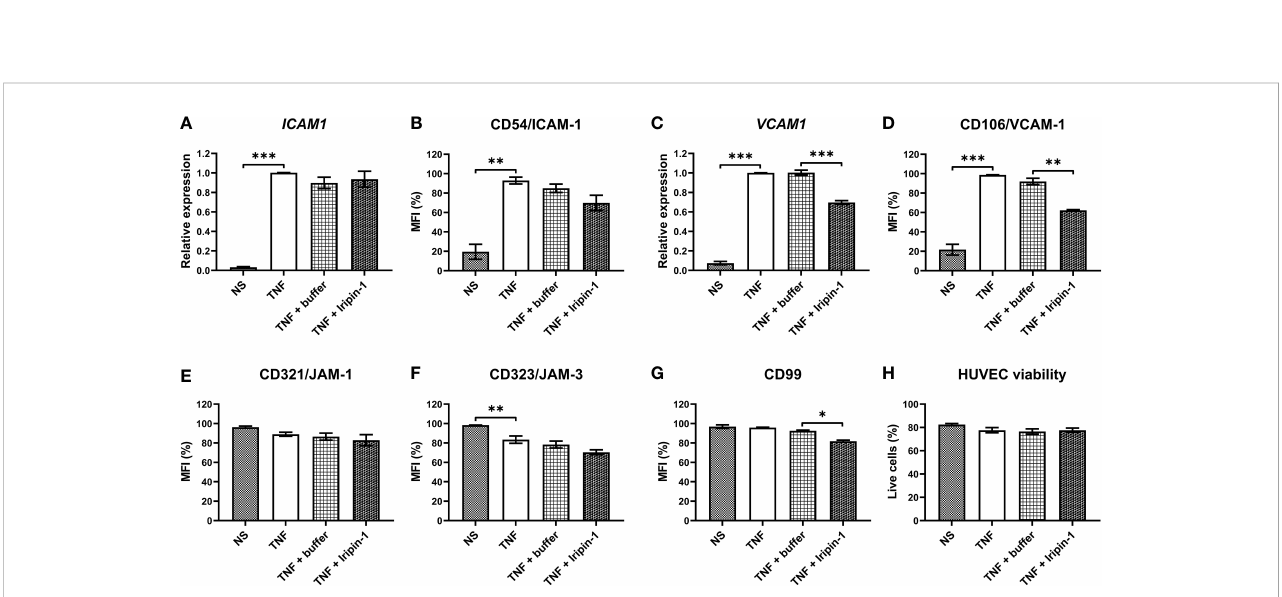
FIGURE 9 Iripin-1 modi fi es the expression of cell adhesion molecules in TNF-stimulated HUVECs. (A, C) HUVEC incubation in the absence of TNF (NS, unstimulated cells) or in the presence of TNF (10 ng/mL), Iripin-1 (2 m M), and control buffer for 4 h was followed by the isolation of total RNA and RT-qPCR analysis to determine the expression level of ICAM1 (A) and VCAM1 (C) . Relative expression values were calculated using the Pfaf fl method (46) and a combination of two reference genes GAPDH and HPRT1 . Cells treated with TNF only were used as a calibrator during calculations. (B, D-H) HUVECs were cultured in the absence of TNF (NS, unstimulated cells) or in the presence of TNF (10 ng/mL), Iripin-1 (2 m M), and control buffer for 6 h and subsequently the cell surface expression of ICAM-1 (B) , VCAM-1 (D) , JAM-1 (E) , JAM-3 (F) , and CD99 (G) together with HUVEC viability (H) were assessed by multicolor fl ow cytometry. The graphs in (B) and (D-G) show the median fl uorescence intensity (MFI) values expressed as a percentage of the highest MFI value (which was set to 100%) measured in each repetition of the experiment, and the graph in (H) shows the proportion of viable HUVECs among single cells. Data in all graphs (A-H) are depicted as mean values of three repetitions of the experiment ± SEM. The statistically signi fi cant differences between the groups NS and TNF, TNF and TNF + buffer, TNF + buffer and TNF + Iripin-1 are marked with asterisks (*p < 0.05, **p < 0.01, ***p <